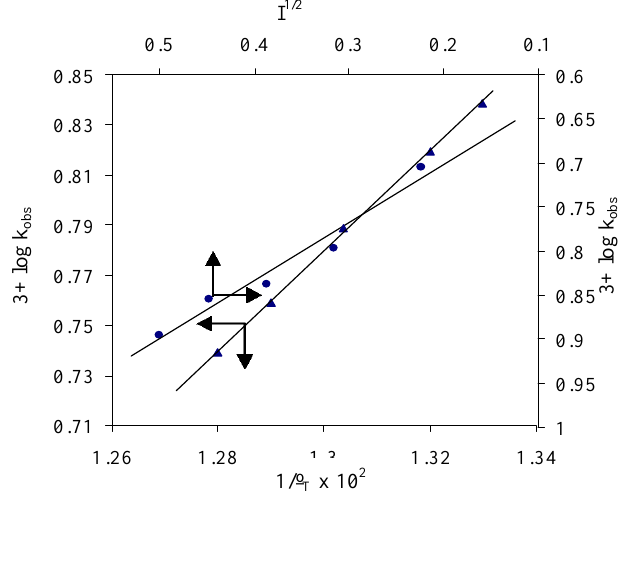
Figure 3Figure 3. Effect of ionic strength (I) and relative permitivity ( ˛ T ) on the DPC oxidation of L-proline in aqueous alkaline medium at 25 o C.